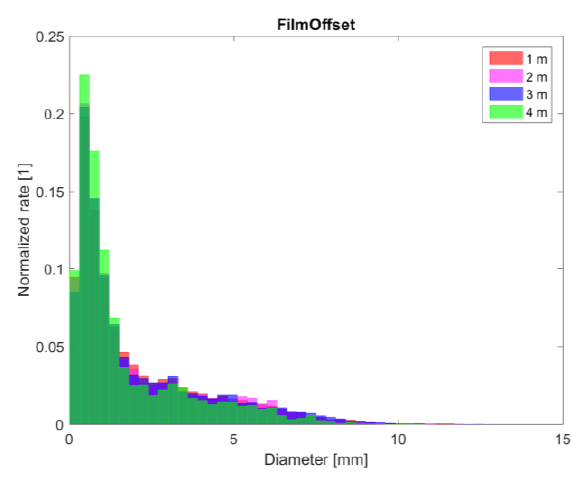
Fig. 8. Histogram of droplets diameters under film fill slope .